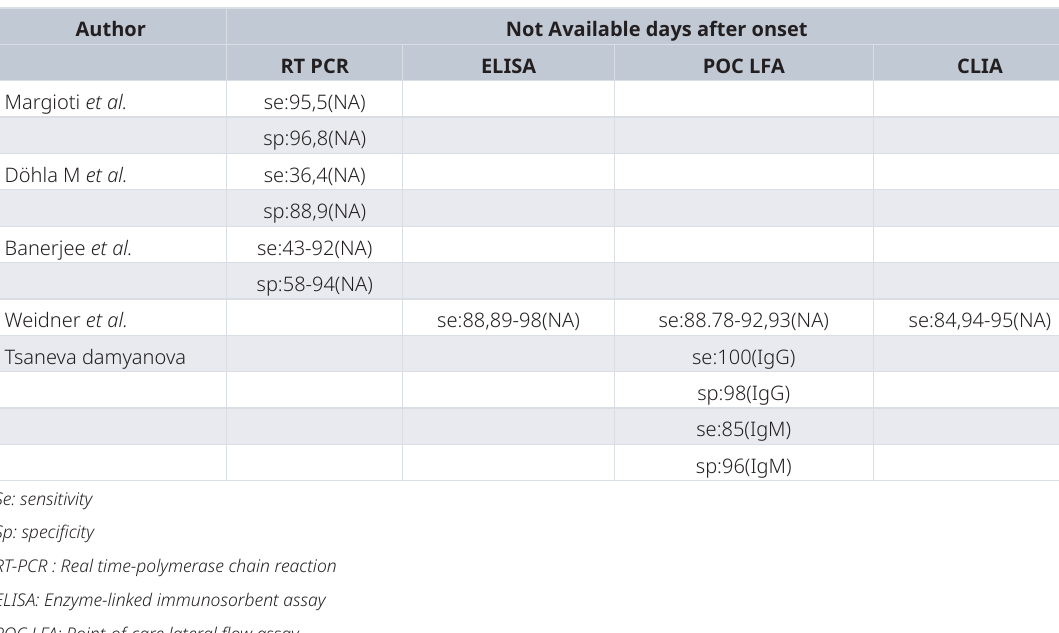
Table 5b. Sensitivity and specificity of diagnostic tests used in the reviewed